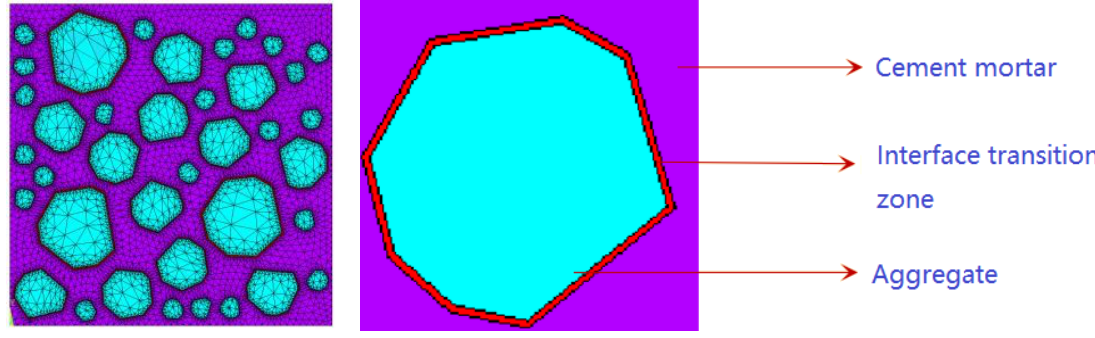
Figure 3: CSG polygon random aggregate model